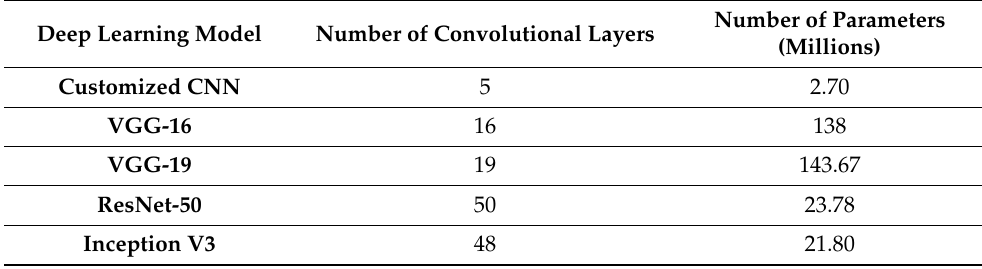
Table 2. Deep Learning Models, with the Number of Convolutional Layers and